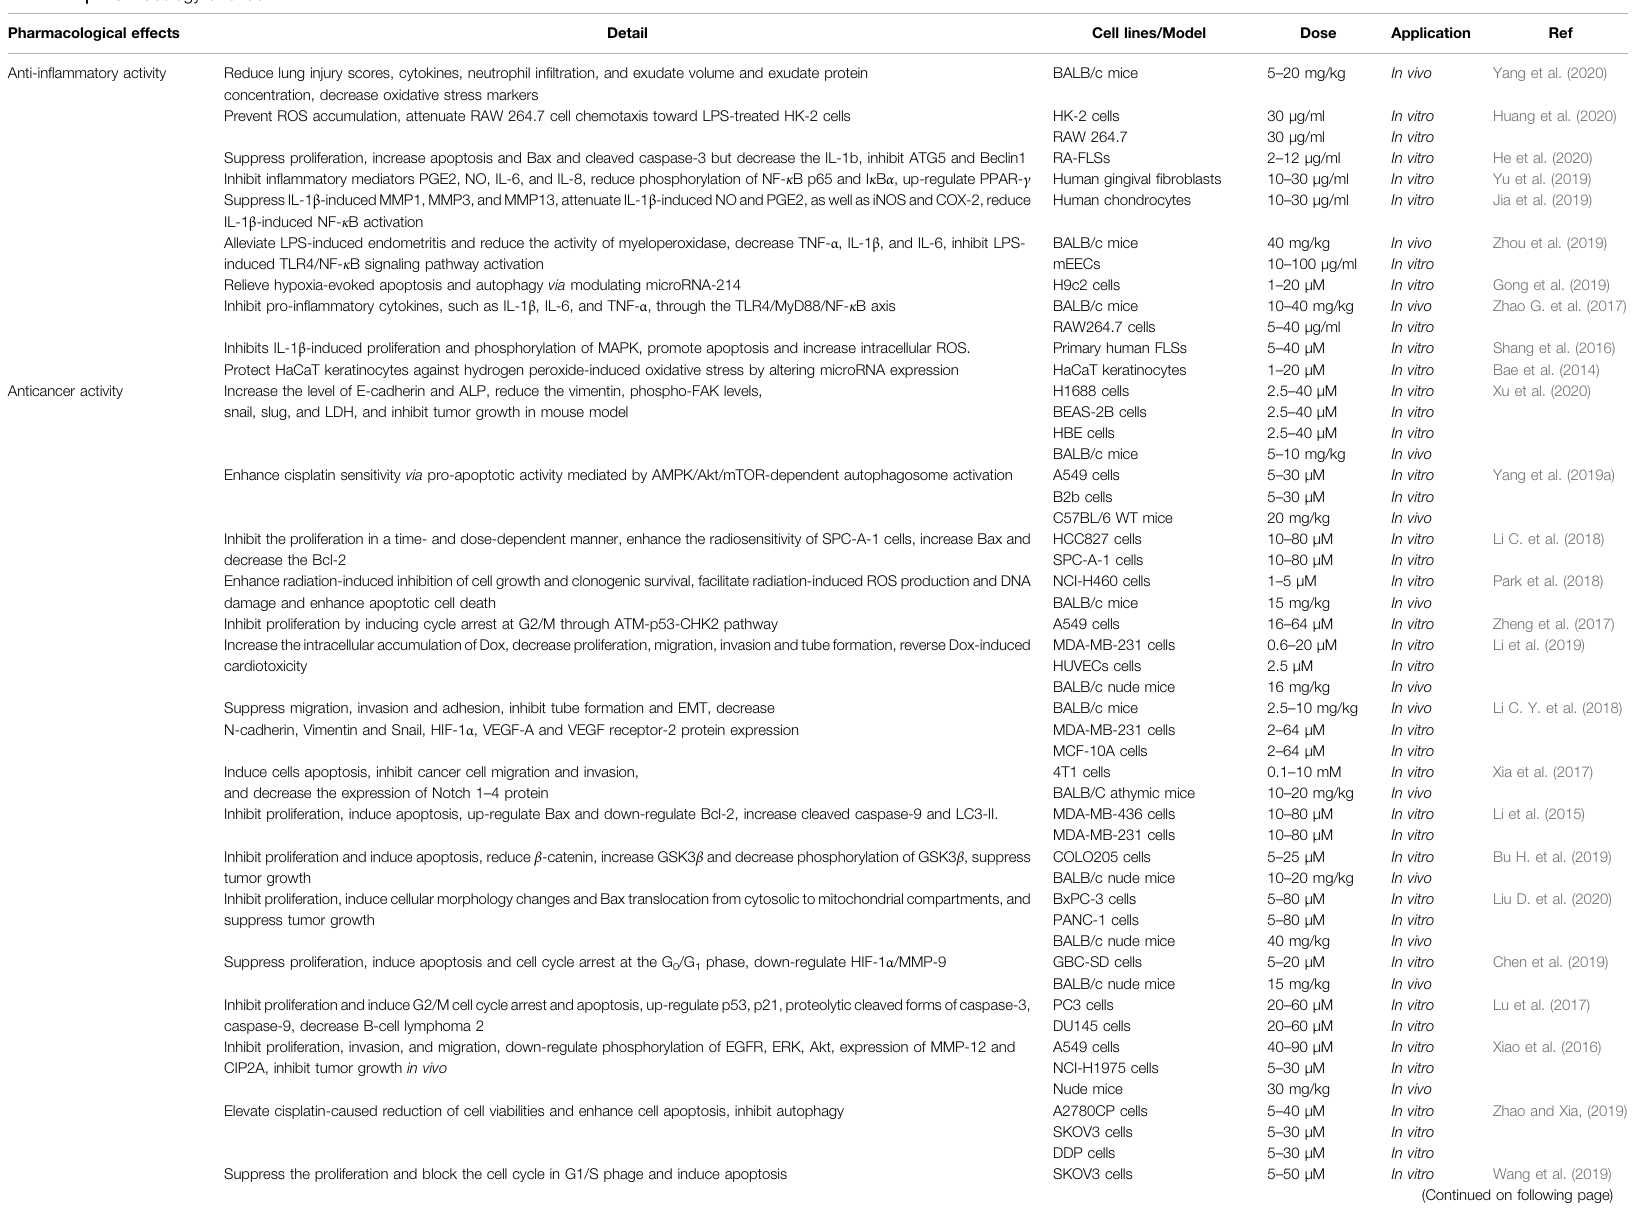
TABLE 1 | Pharmacology of